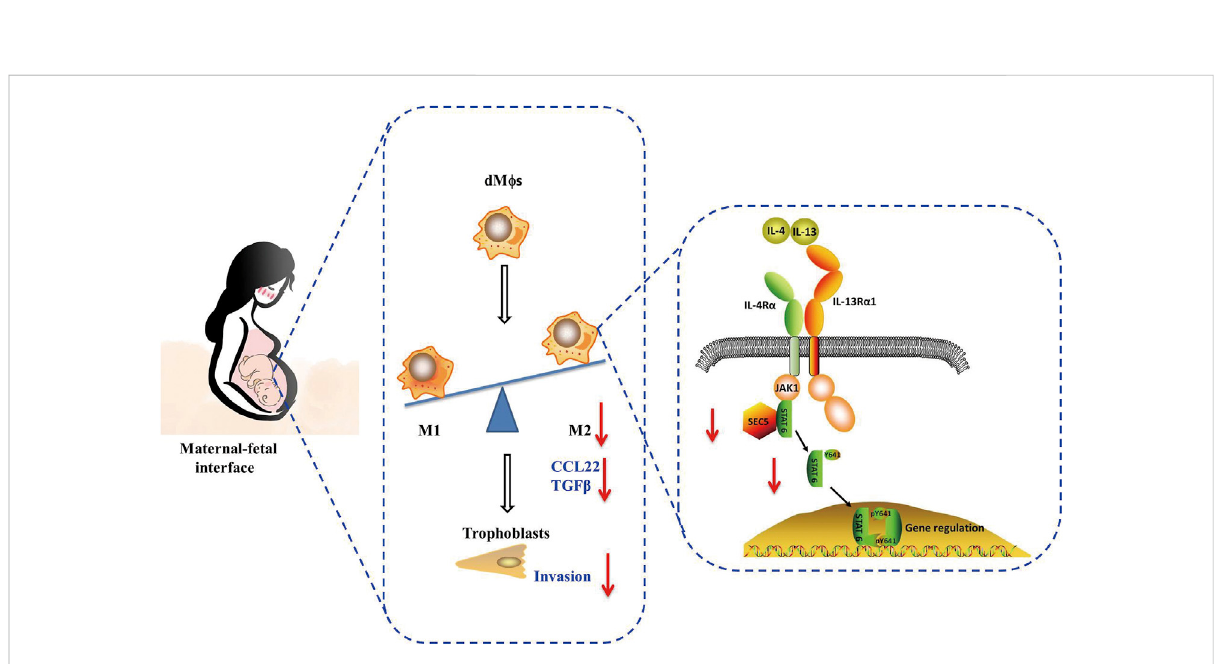
FIGURE 7 A schematic diagram of the impairment of macrophage M2 polarization induced by low SEC5 expression at the maternal – fetal interface in patients with RSA. SEC5 regulates STAT6 phosphorylation through its interaction with STAT6, thereby leading to macrophage M2